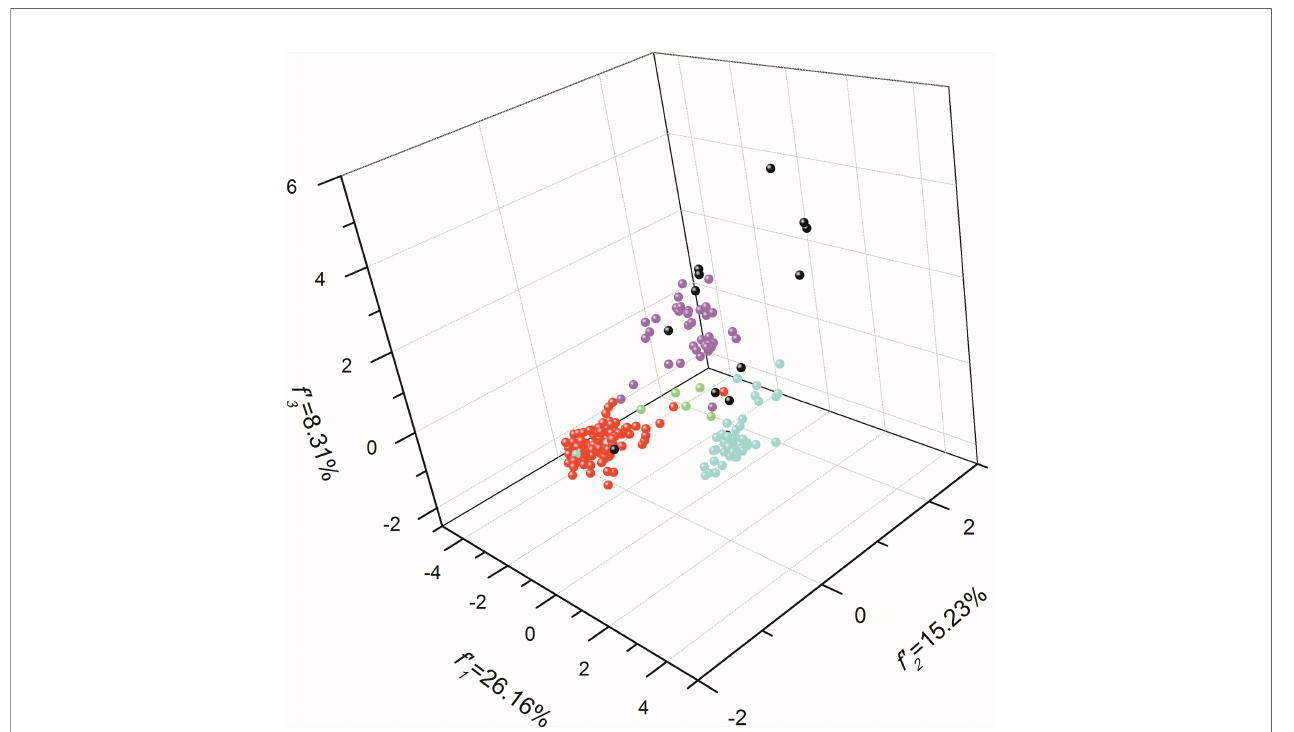
FIGURE 7 | The plot for the overall codon usage visualized by PCA method for atg13 genes of 226 eukaryotic organisms. The red dots mean mammals, the blue dots stand for Sauropsida animals, the purple dots mean fi shes, the green dots mean amphibians, and the black dots correspond to the rest eukaryotic organisms in this